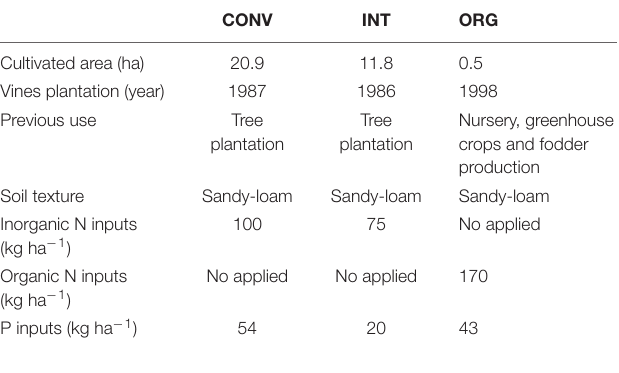
TABLE 1 | Agricultural management history, soil texture and chemical inputs at the conventional (CONV), integrated (INT), and organic (ORG) kiwifruit orchards in